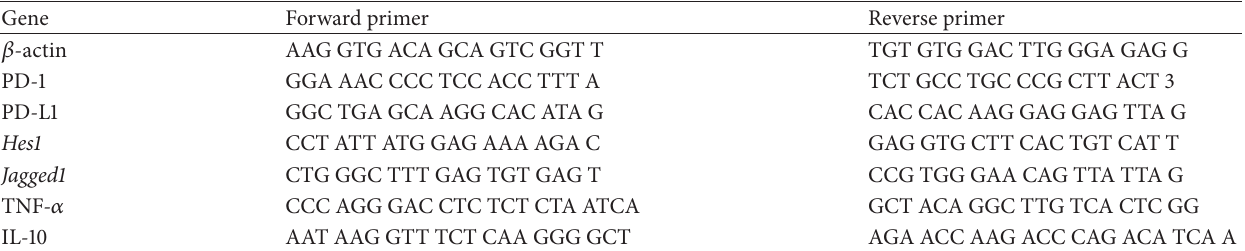
Table 1: Primer sequences used in the real-time quantitative polymerase chain reaction.